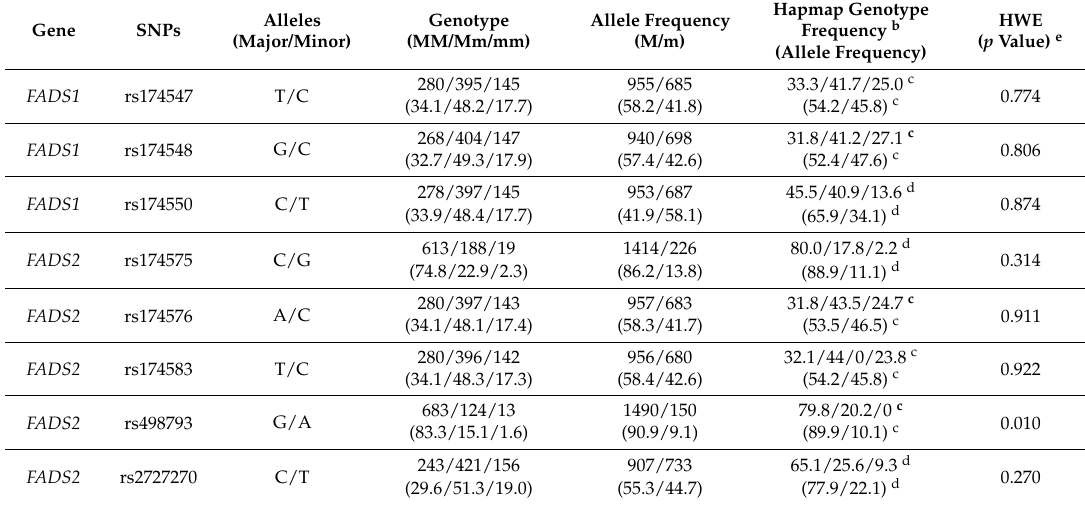
Table 2. Genotype and allele distribution of FADS polymorphisms among 820 type 2 diabetes patients a .